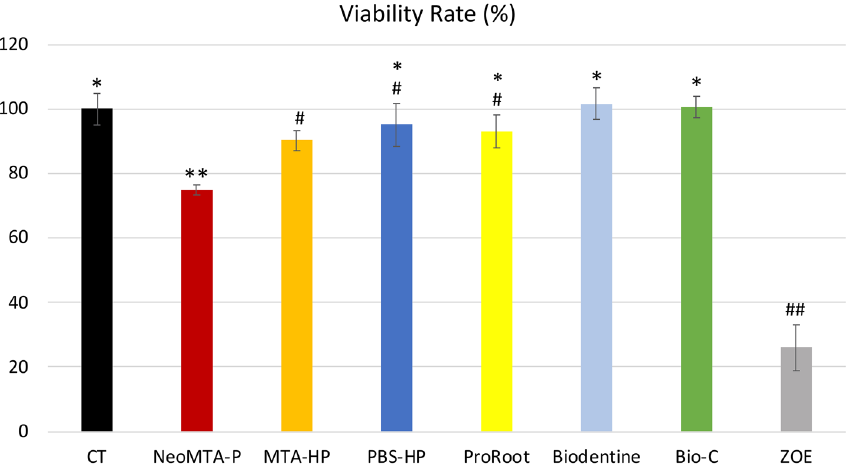
Figure 1. Cell viability rates. CT, positive control group (unexposed cells). NeoMTA-P, MTA-HP, PBS-HP, ProRoot, Biodentine, Bio-C, and ZOE (negative control) were the groups of cells exposed to the respective types of cement. The viability rates of the cells exposed to PBS-HP, ProRoot, Biodentine, and Bio-C were similar to those of the control group. However, NeoMTA-P and MTA-HP exposure led to a significantly lower viability rate than CT. Data are presented as mean ± SD; one-way ANOVA, followed by multiple comparisons post- hoc test with Bonferroni’s test. Symbols on the chart indicate homogeneous groups by Bonferroni’s posttest. *p < 0.005, all groups versus CT; **p < 0.001, comparisons among cement groups; # p < 0.005, comparisons among cement groups; ## p < 0.001, ZOE versus all